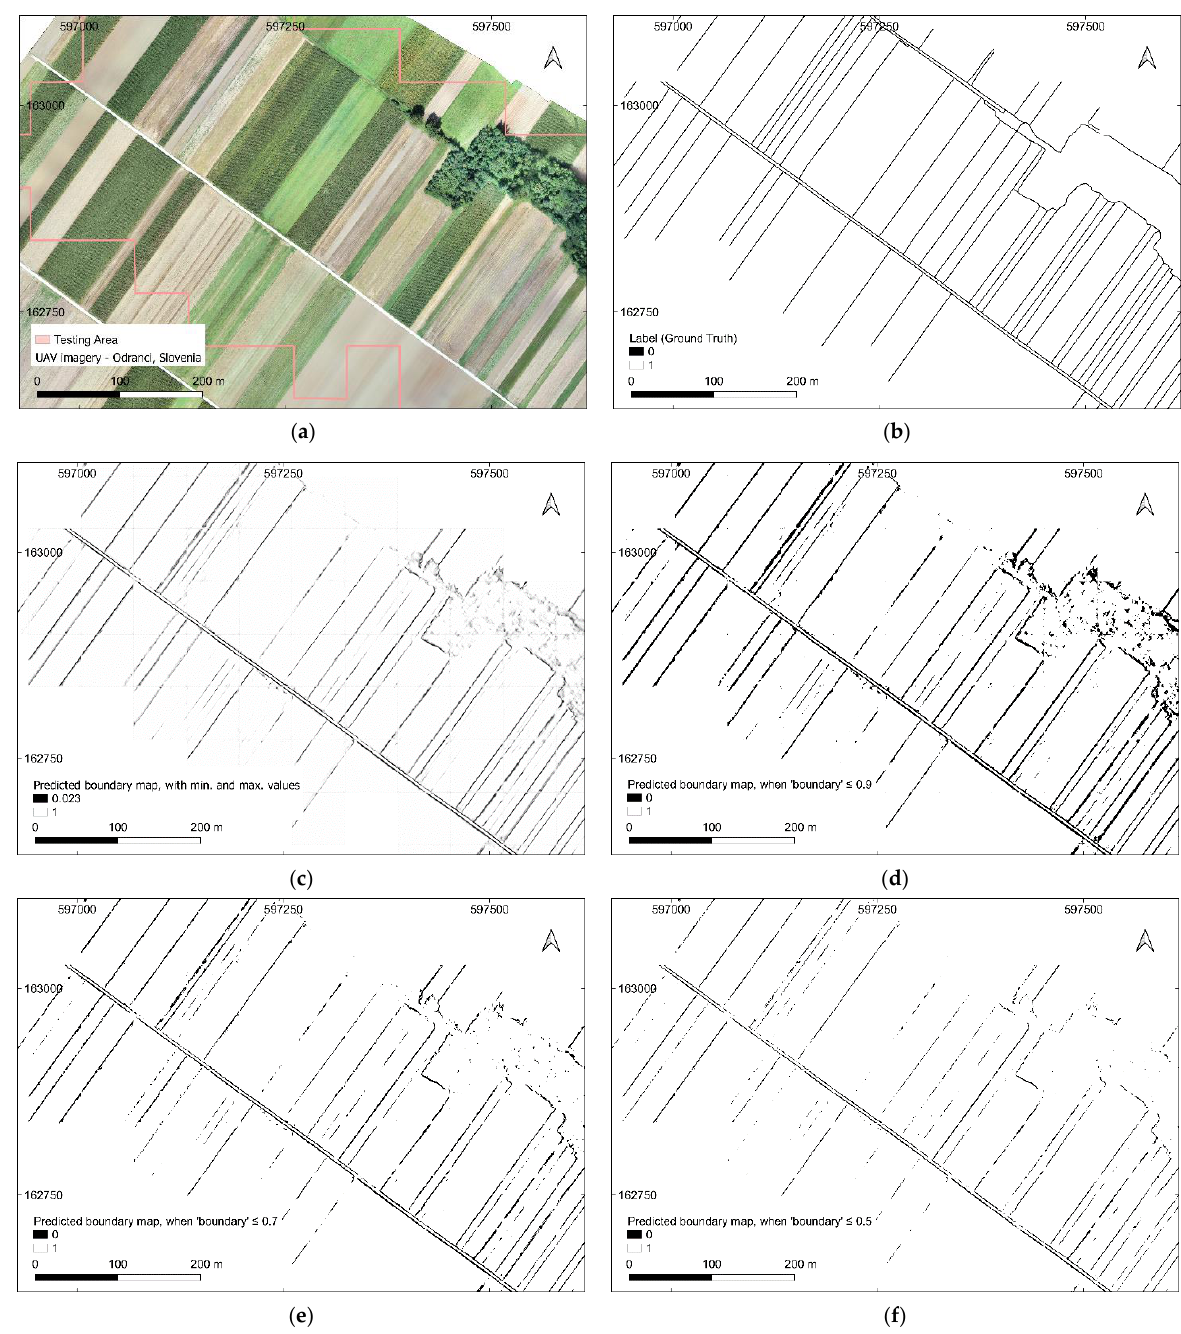
Figure 8. ( a ) Test UAV area; ( b ) label image; ( c ) predicted boundary map (0–1); reclassified boundary maps when ( d ) ‘boundary’≤ 0.9; ( e ) ‘boundary’≤ 0.7; ( f ) ‘boundary’≤ 0.5.